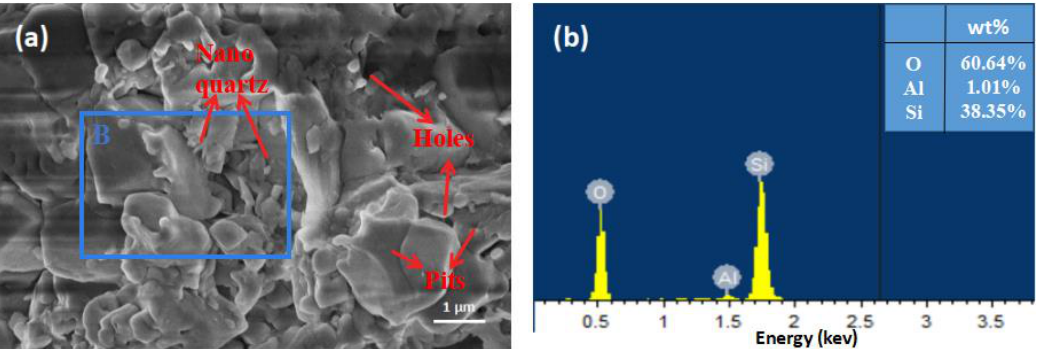
Figure 5. ( a ) SEM image of the carbon-free sample and ( b ) EDS pattern of area B.